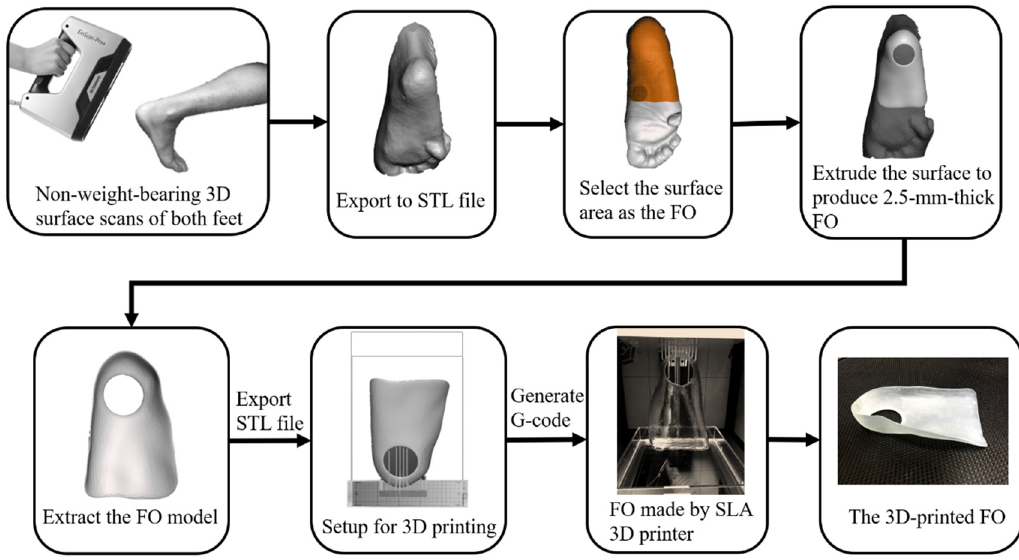
Figure 1. Procedure of 3D printing for foot orthoses.